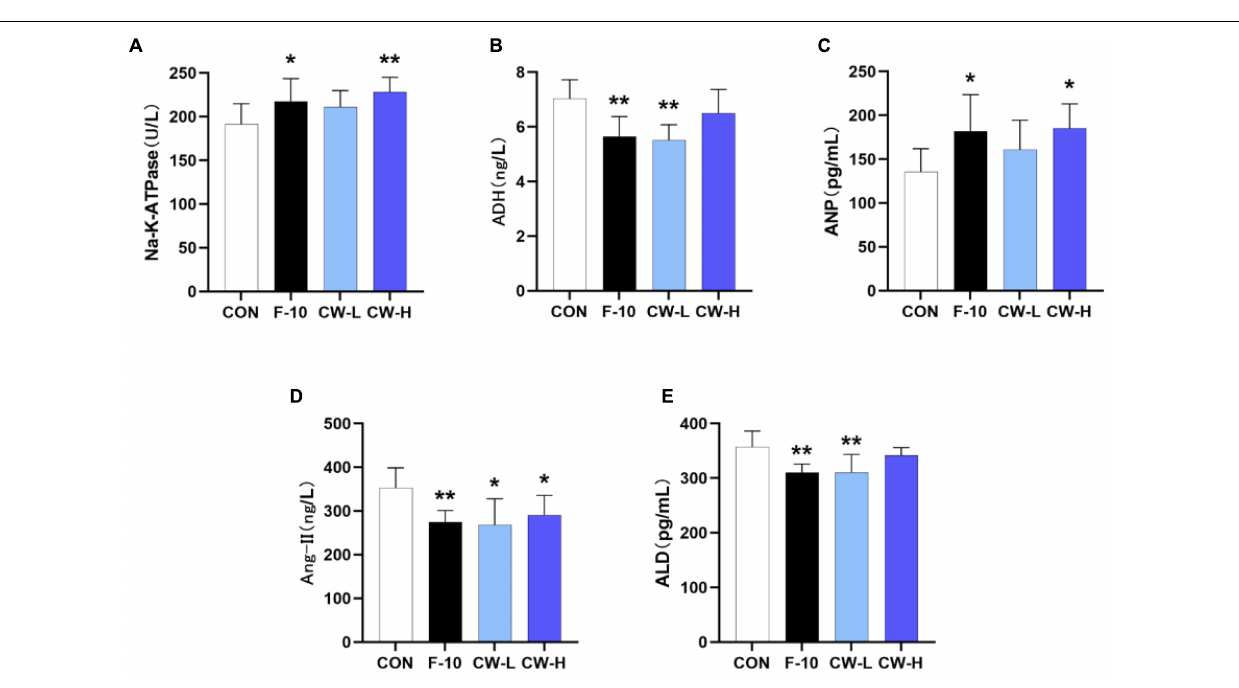
FIGURE 2 | Effect of coconut water on Na + -K + -ATPase (A) , ADH (B) , ANP (C) , Ang II (D) , and ALD (E) in serum levels of rats. Values are expressed as mean ± SD ( n = 9), * p < 0.05 and ** p < 0.01 compared to the control